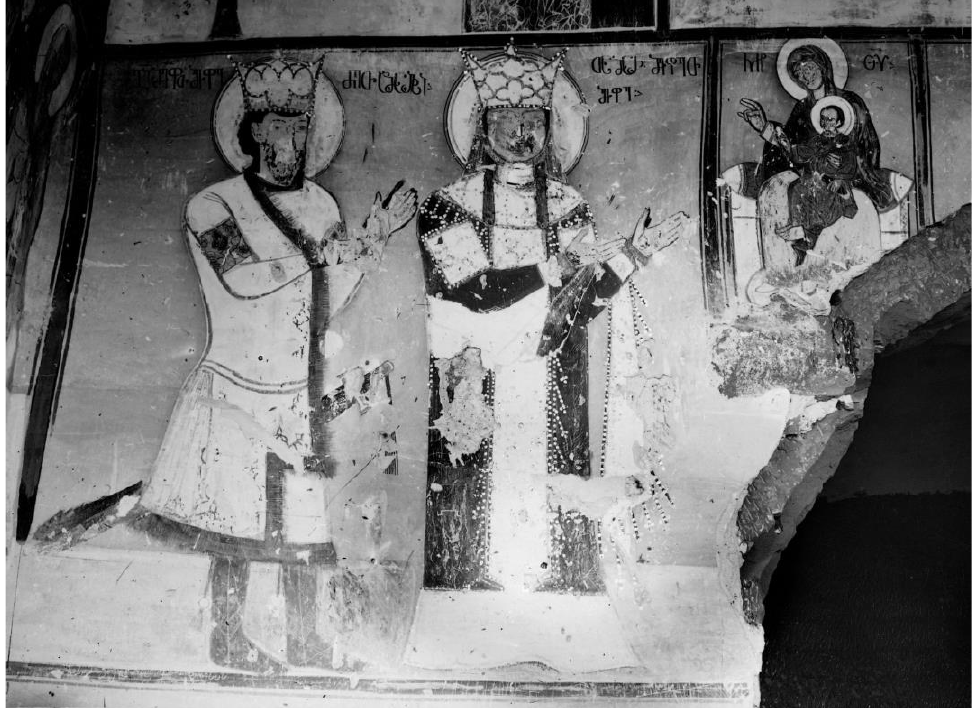
Figure 5. King Giorgi IV Lasha alongside his deceased mother Queen T’amar, fresco, 1220s, church of the Virgin at Bert’ubani monastery, Gareja desert (Archival photograph from Zaza Skhirtladze’s